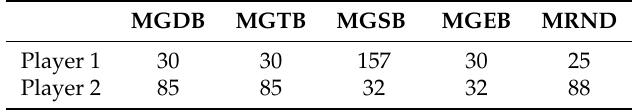
Table 3. Suggested initial nodes based on different